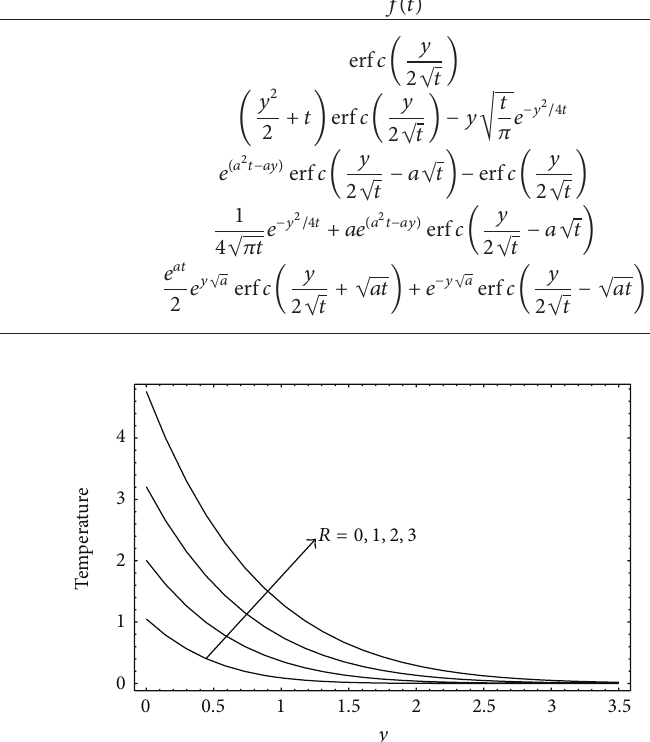
Figure 12: Temperature profiles for different values of 𝑅 when 𝑡 = 0.2, Pr = 0.71 , and 𝛾 = 1 .